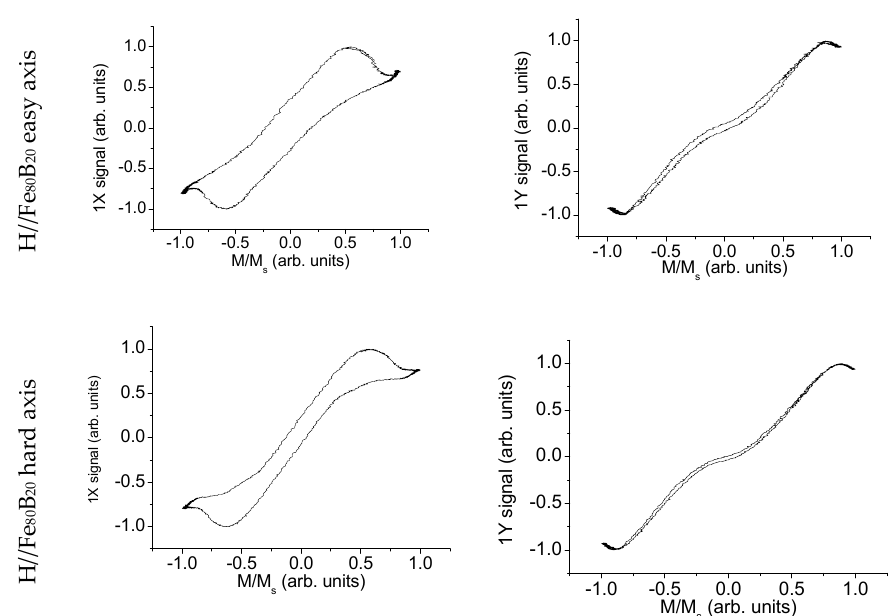
Figure 3. Experimental 1st order diffracted magneto-optic (MO) signal vs. average magnetisation for arrays of 5 µ m edged Fe 80 B 20 squares separated 1 µ m. Data are shown when the field is applied both along the easy (top row) and the hard Fe 80 B 20 axis (bottom row) and parallel to the square edges.